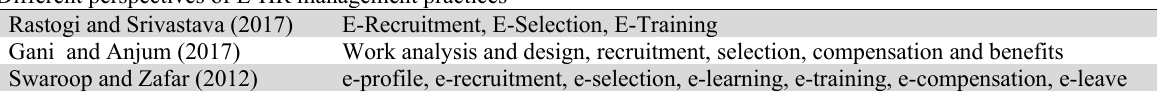
Table 1 Different perspectives of E-HR management practices Rastogi and Srivastava (2017) E-Recruitment, E-Selection, E-Training Gani and Anjum (2017) Work analysis and design, recruitment, selection, compensation and benefits Swaroop and Zafar (2012) e-profile, e-recruitment, e-selection, e-learning, e-training, e-compensation,